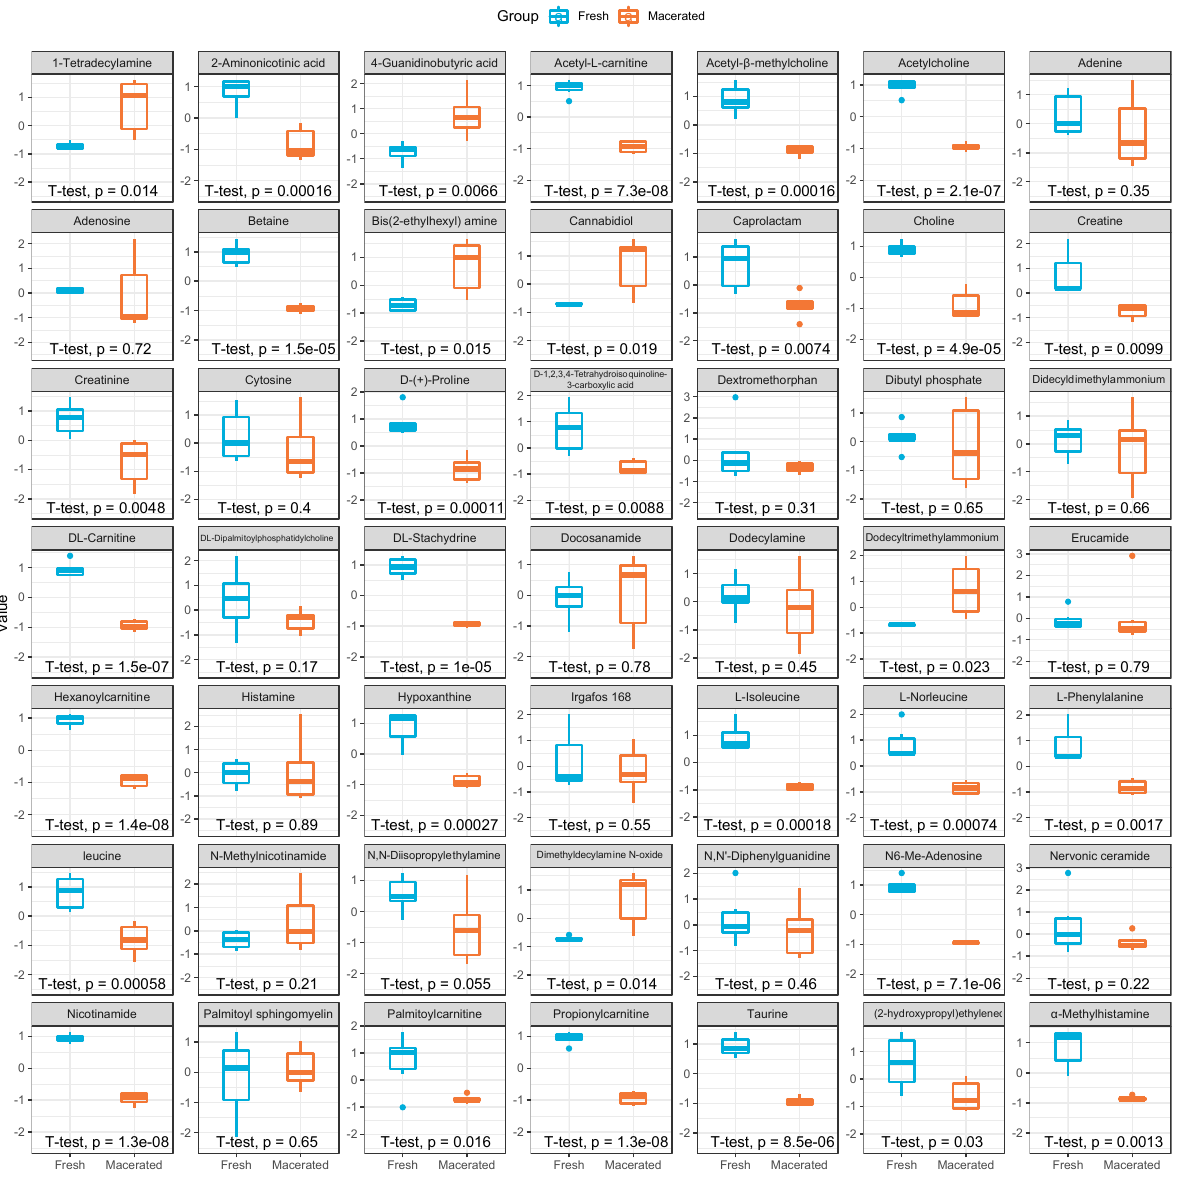
and lysophosphatidylserine (LPS). Boxplots and t -test results are reported, respectively, in Figure S2 and Table S1. Regarding lipidomics ESI − (Figure S3 and Table S1), significant differences were seen for ceramides with higher abundances for the fresh samples. The same trend was seen for PSs and one LPS. In contrast, LPCs, LPEs, PCs and PIs show higher abundances in the macerated samples confirming what also shown by lipids profiled in ESI+ mode.